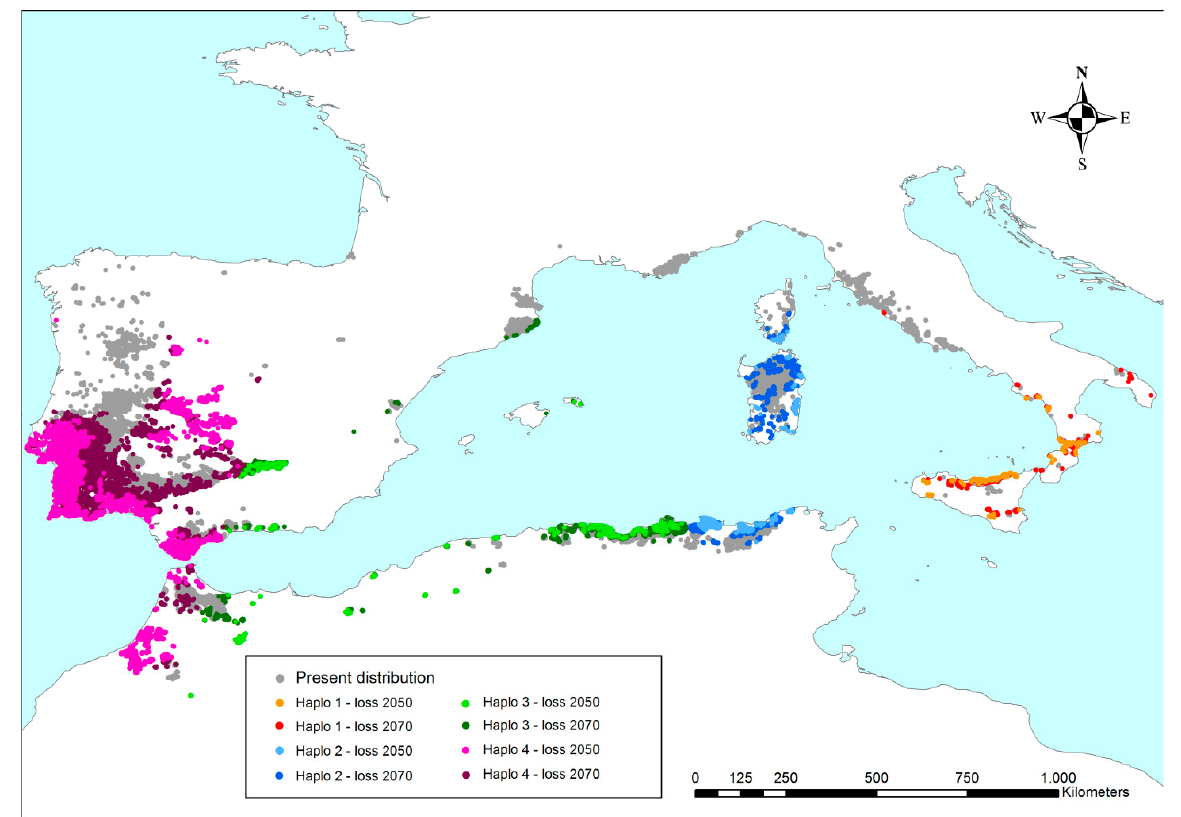
Figure 7. Cork oak distribution in the Mediterranean. Colors refer to haplotypes and to the areas that will have Q-m values outside of the species climatogram in the next decades (see Figures 4–6); thus, they are not climatically suitable for the persistence of cork oak. Grey areas represent those sites where the species will keep safeguarded to increase their probability of enduring the conditions over time.